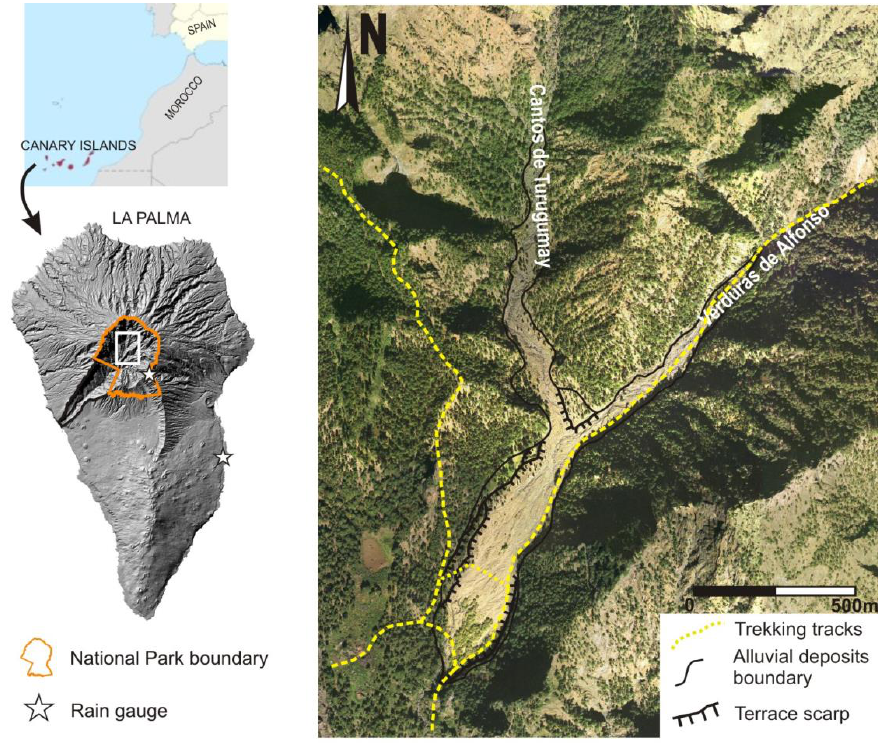
Figure 1. Map showing location of the “Playa de Taburiente” area, within the Caldera de Taburiente National Park, with main features of interest. National Park, with main features of